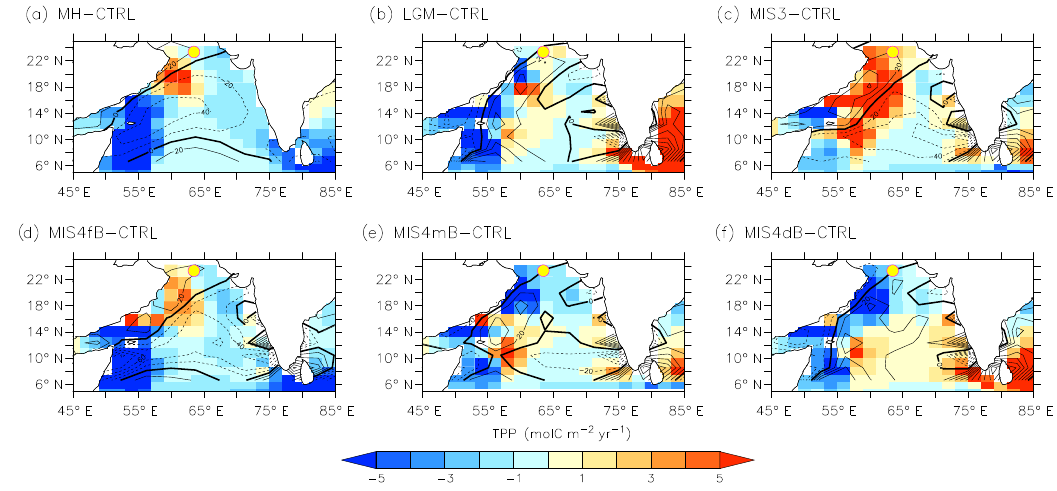
Figure 8. Seasonal (JJAS) productivity (molCm − 2 yr − 1 , colour scale) and Ekman pumping (black contour every 20myr − 1 ) changes com- pared with the CTRL simulation for the (a) MH, (b) LGM, (c) MIS3, (d) MIS4F, (e) MIS4M and (f) MIS4D simulations in the Indian Ocean. The yellow circle indicates the position of core MD04-2873 used later in this paper.